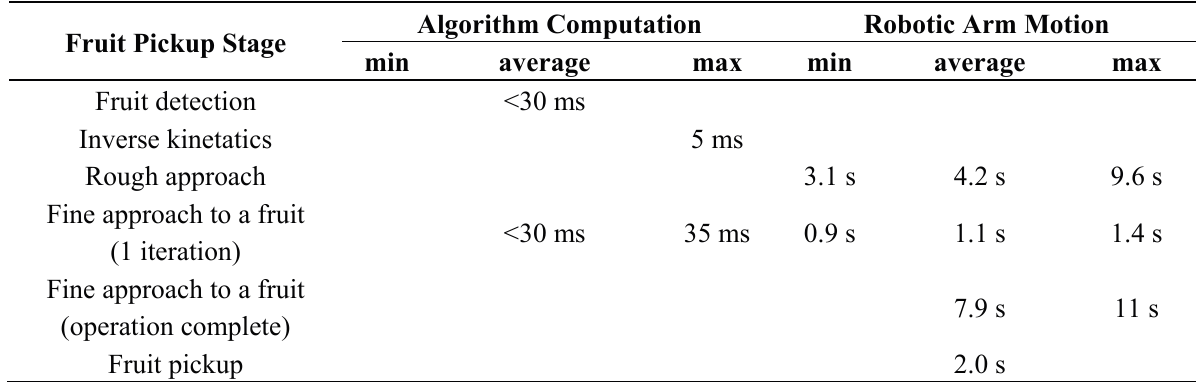
Table 10. Fruit pickup